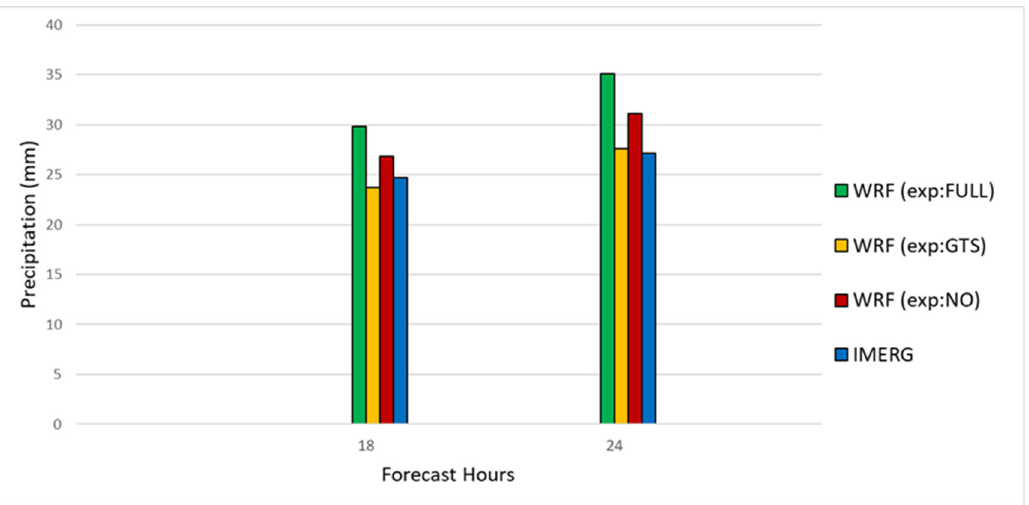
Figure 18. Bar chart depicting the average spatial values of the accumulated precipitation in mm from 12 to 18 UTC on 18 September 2020 for the high-resolution domain. Green corresponds to the FULL experiment forecasts, yellow to the GTS experiment, red to the NO experiment, and blue to the IMERG precipitation product.